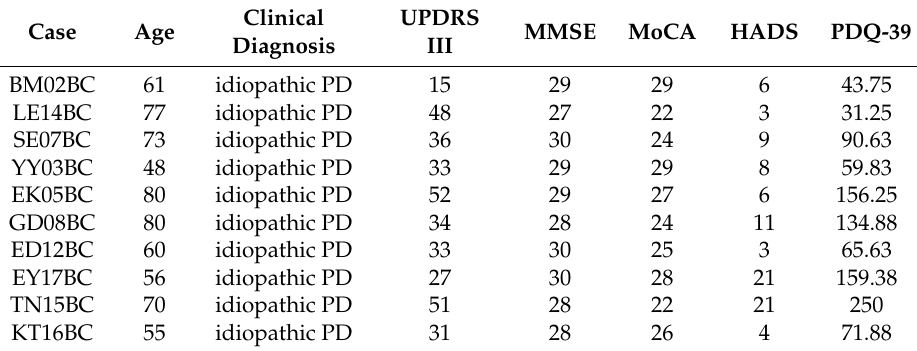
Table 1. Clinical information of 10 male PD patients before BCA